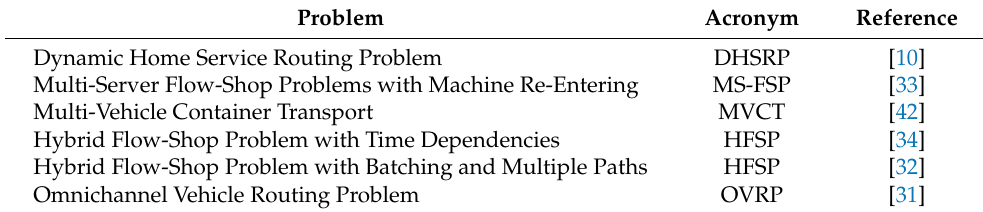
Table 1. Selected optimization problems.